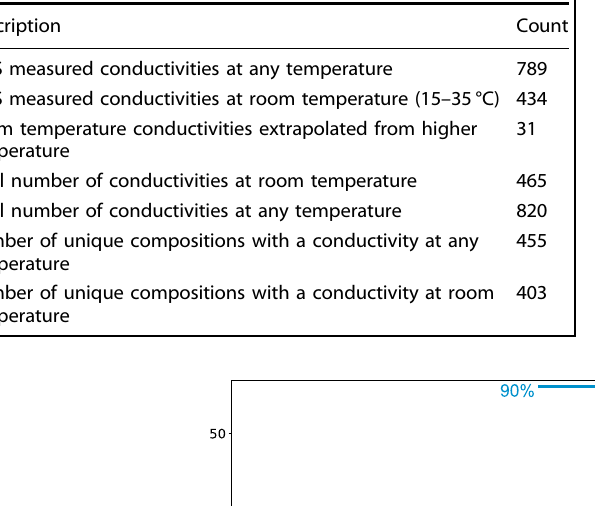
Table 1. The number of experimentally reported conductivities contained within this dataset.